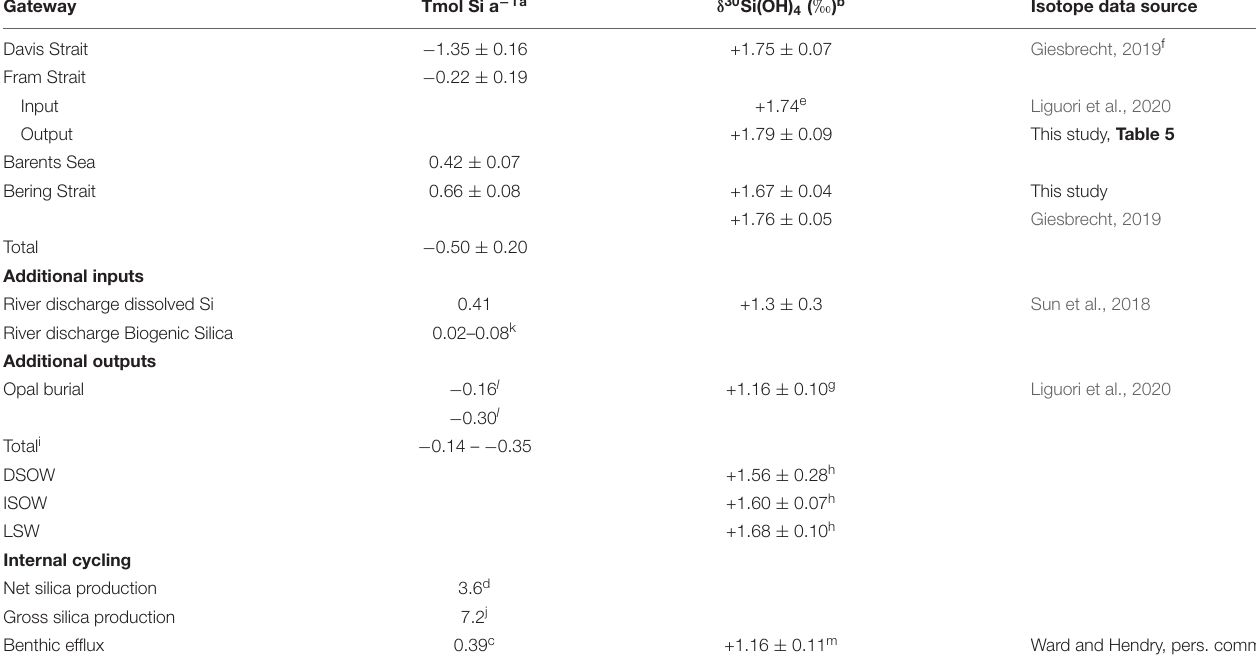
TABLE 2 | Silicic acid and Si isotope budget for the Arctic Ocean.